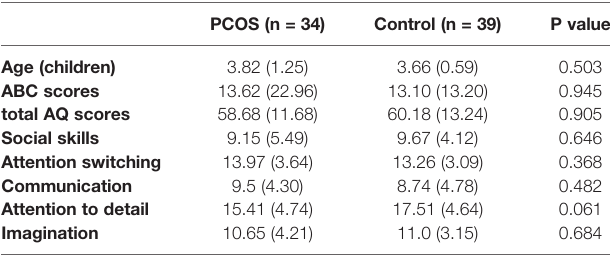
TABLE 4 | Comparisons of age, ABC score, total AQ score, and AQ subscale scores between the two groups of children. PCOS (n = 34) Control (n =